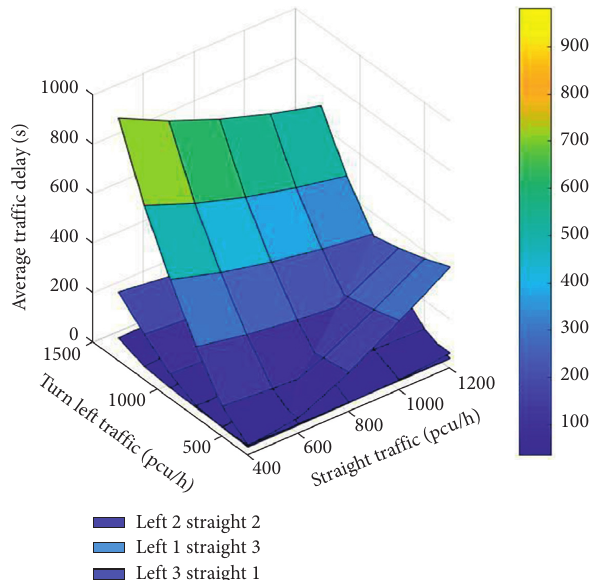
Figure 11: Change in the two-way delay under different lane combinations on four entrance